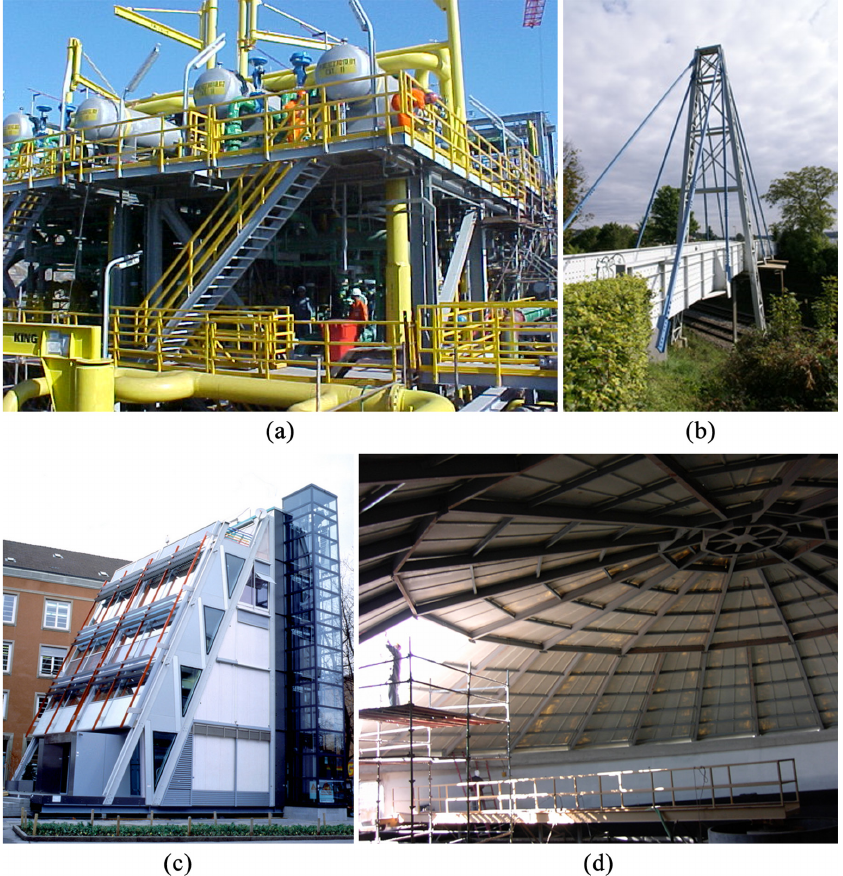
Figure 1. Applications of structural GFRP – (a) Stairs and decking in Brazil 7 (b) Kolding Footbridge in Denmark 8 , (c) Eyecatcher Building in Switzerland 9 , (d) ETAR Vila Moura in Portugal 10 .